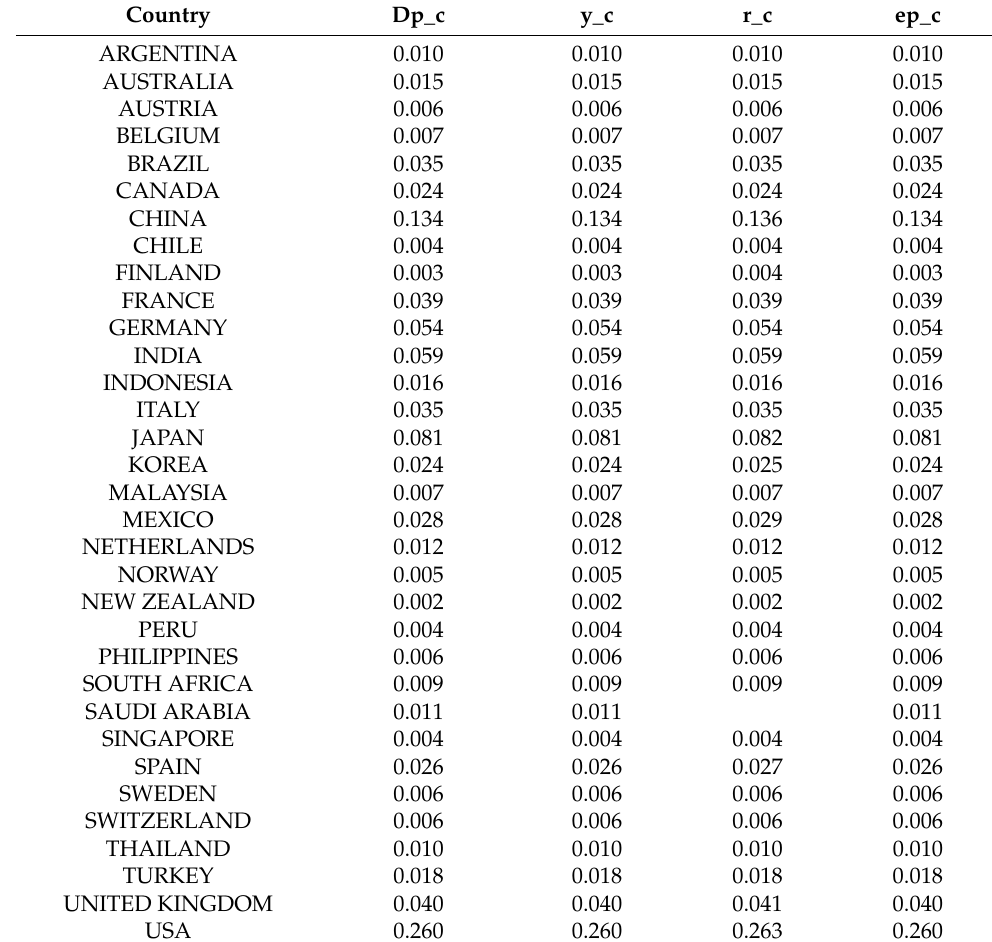
Table A5. Country Weights DSGE-GVAR.